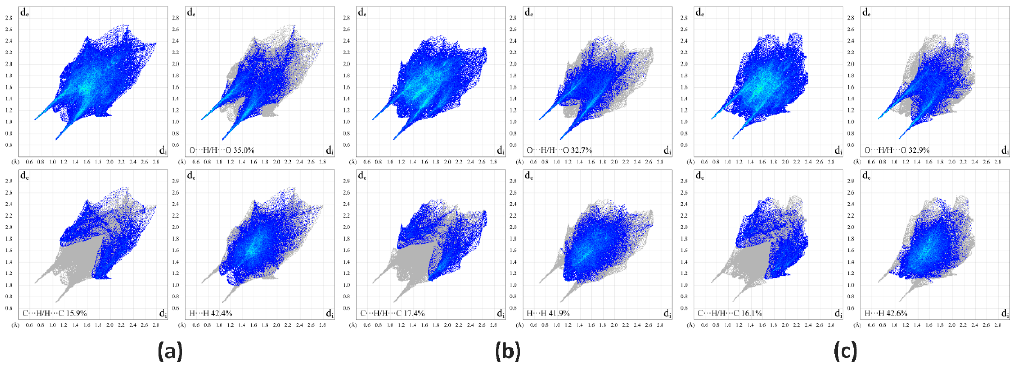
Figure 5. Two-dimensional fingerprint plots of I ( a ), II -A ( b ), and II -B ( c ), showing the contribution of each type of contact within the molecule.